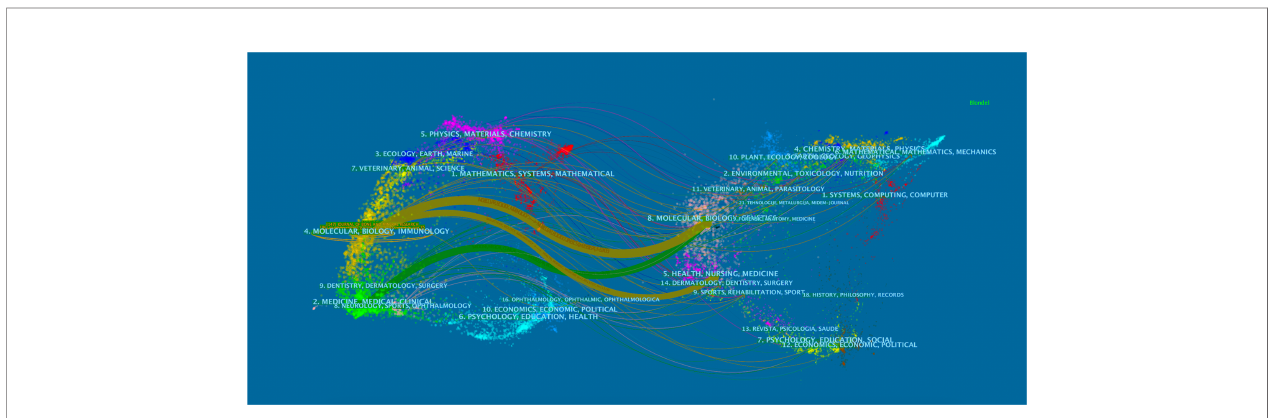
FIGURE 3 | Dual-map overlay of journals related to osteoblasts-osteoclasts in bone disease. Notes: The citing journals are on the left, the cited journals are on the right, and the colored path represents a citation